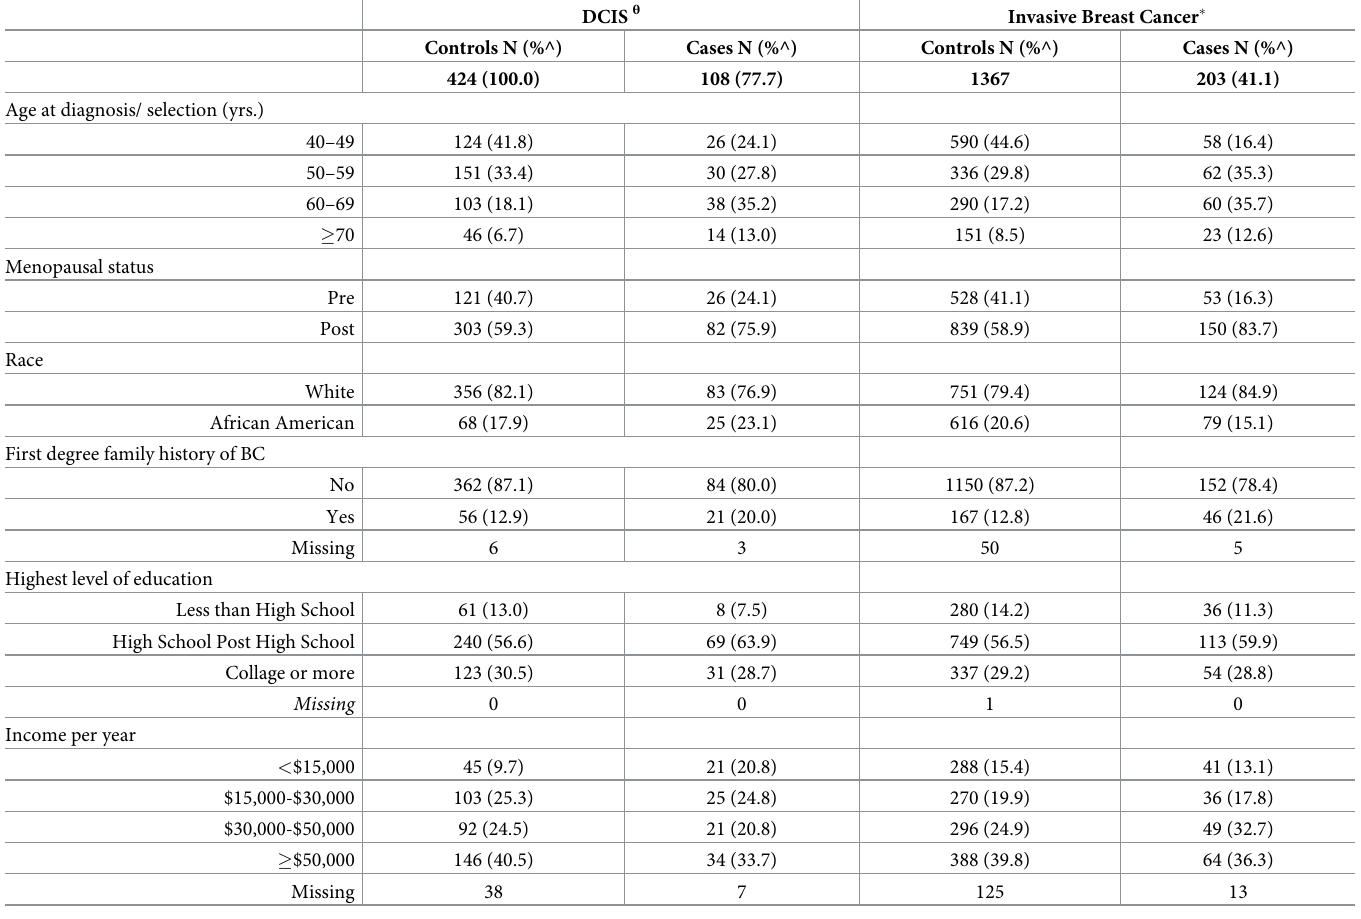
Table 1. Socio-demographic characteristics of screen detected Luminal A DCIS and invasive breast cancer in the Carolina Breast Cancer Study, Phases 1–2 (1993–